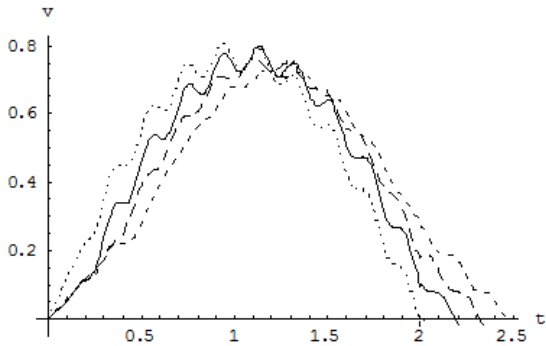
Figure 23: The influence of the vehicle length for R = 150 m, υ = 30 m/s, e H = 3.00 m, e V = 1.20 m and d = 3 m ( __ ), d = 5 m ( _ _ ), d = 7 m (- - - ) and d = 0 m ( .... ).